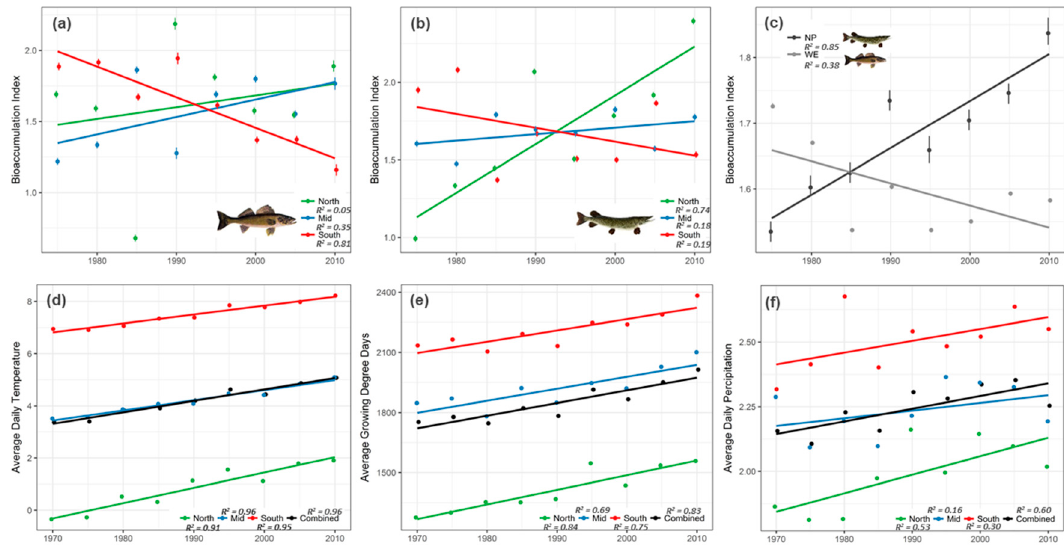
Figure 3. Spatiotemporal trends of mercury bioaccumulation in ( a ) Walleye and ( b ) Northern Pike as predicted by the random slopes of the full model with time period and latitudinal zone interactions as random effects. Temporal trends in bioaccumulation for both Walleye and Northern Pike are shown in ( c ) as the predicted random slopes of the full model with time period alone as the random effect. Error bars indicate ± 1SD. Change in climatic conditions are shown as spatiotemporal trends in ( d ) temperature, ( e ) growing degree days and ( f ) precipitation based on average measures at Environment Canada sampling stations, estimated from aggregated 5-year time periods. Table 5. Summary statistics of LMEMs describing fine-scale (waterbody-level) variation in body mass as a function of age with each unique waterbody sampled treated as a random effect for Walleye and Northern Pike. (Note: numbers in parenthesis show 95% confidence interval).